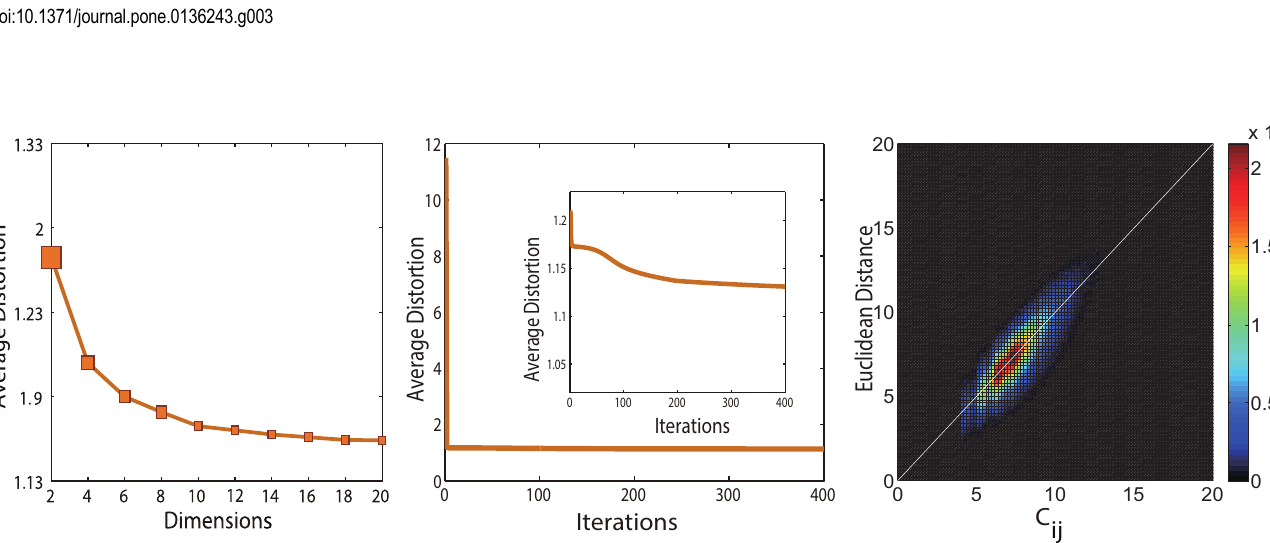
Fig 4. The effectiveness of the embedding. (A) The average distortion of embedding algorithm decreases with the embedding dimension. (B) The average distortion of embedding algorithm in different iterations. The inset shows the enlarged lower left corner of the line. (C) shows the relationship between all the Euclidean distances and the flow distances as the final best results of the embedding.